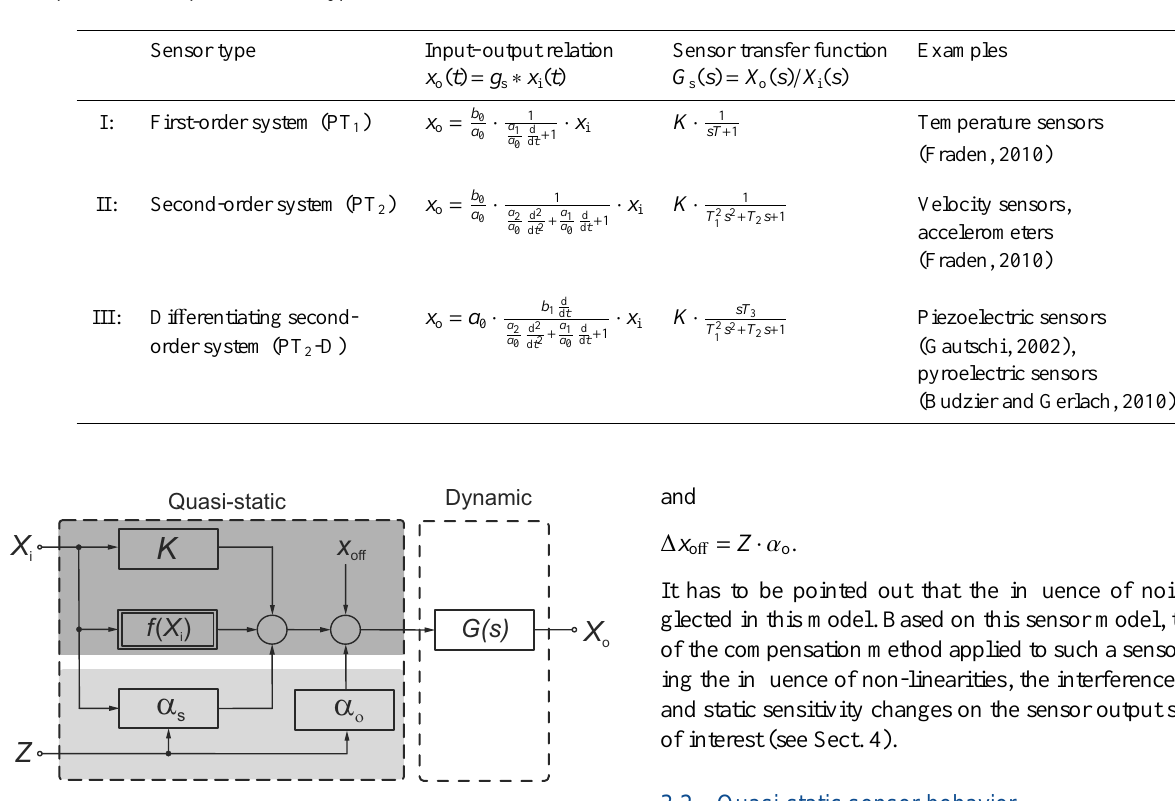
Table 2. Sensor classification and assignment of the respective input–output relations and resulting transfer functions as well as common examples for the respective sensor types.